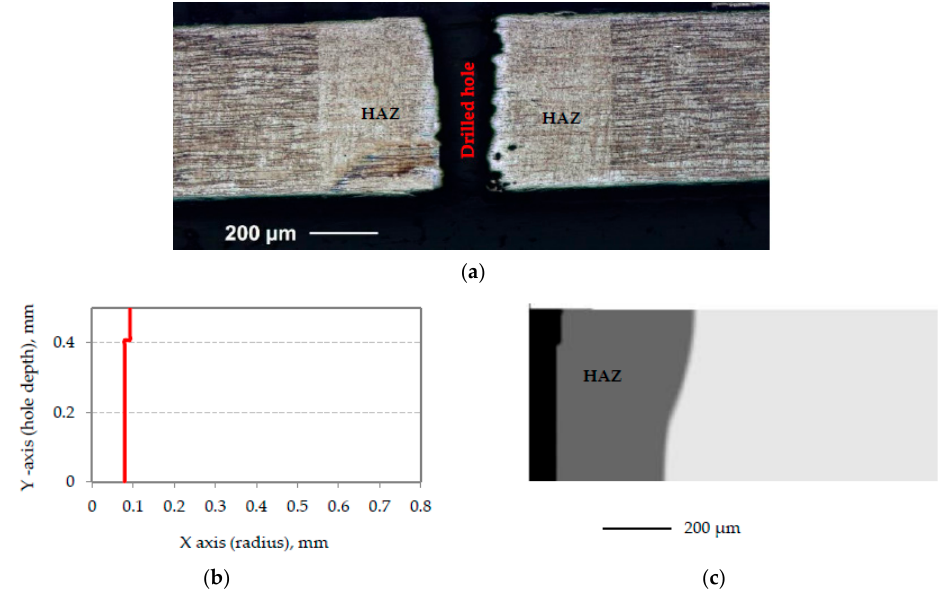
Figure 8. Heat-affected zone (HAZ) and the shape of the drilled hole for a 0.5-mm-thick tungsten alloy plate: ( a ) Experiment; ( b ) FVM—shape of the hole; ( c ) FVM—heat-affected zone.